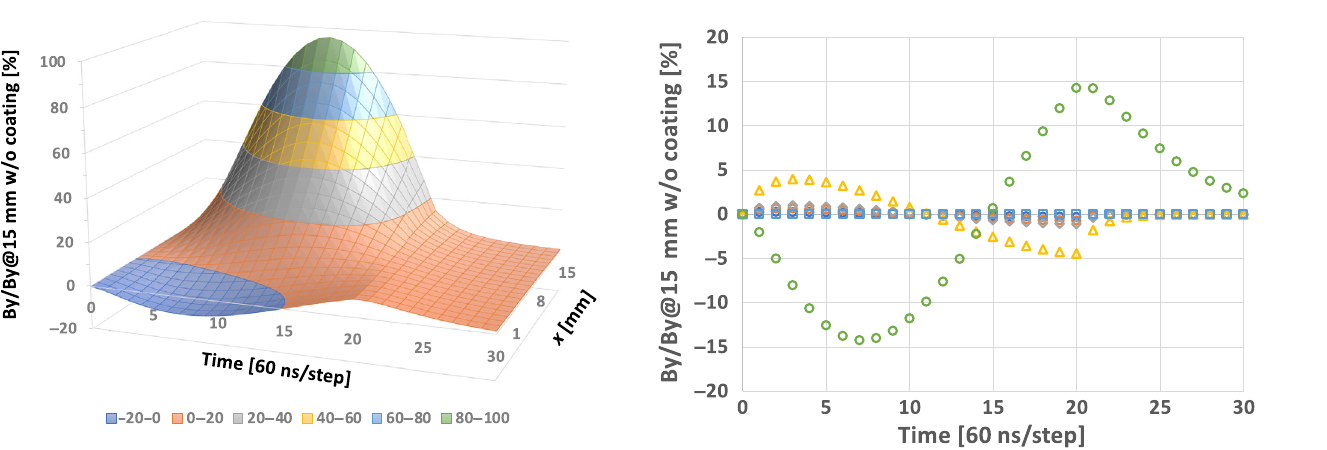
FIG. 12. Suppression of the eddy-current magnetic field at the center of the magnet, through which the stored beam